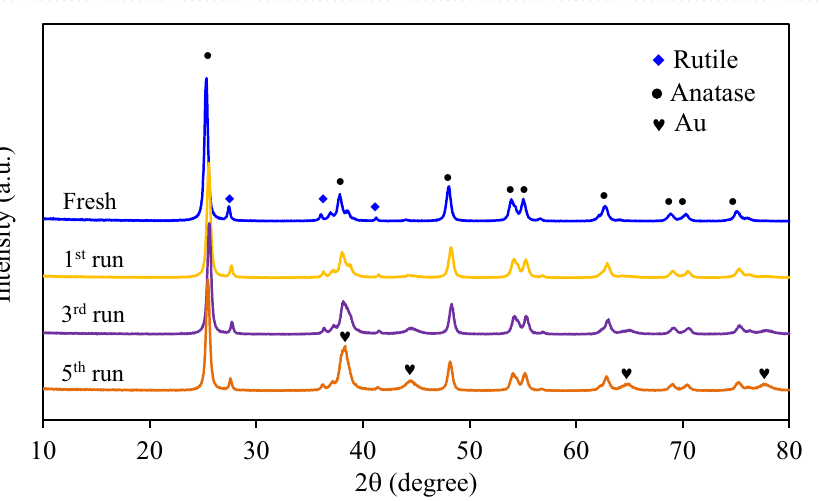
Figure 15. Representative XRD analysis of Au 0.5 /TiO 2 photocatalyst after repetitive runs at loading of 1.0 g/L and light intensity of 3.20 mW/cm 2 in the presence of 20 vol% CH 3 OH as the hole